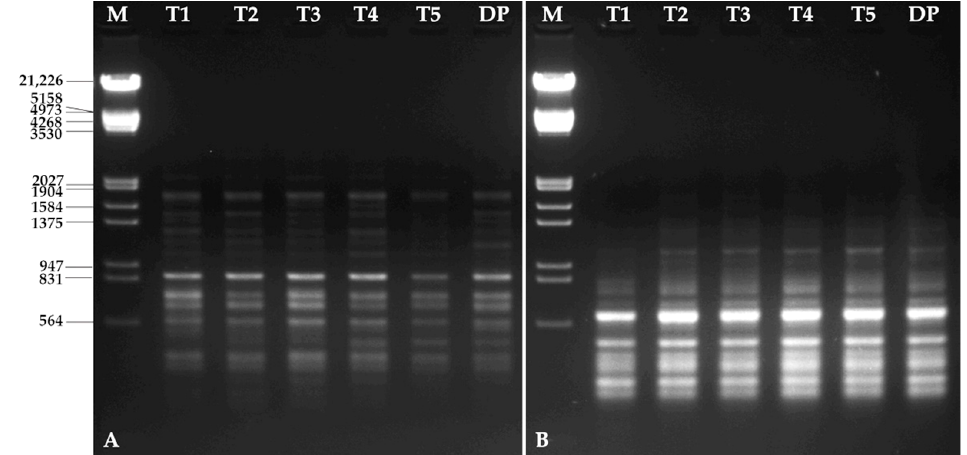
Figure 5. DAMD-PCR profiles of tissue culture and donor plants of Plectranthus amboinicus : ( A ) profile generated using primer HVB5 and ( B ) profile generated using primer 33.6. Lane M = Lambda DNA/EcoRI+HindIII marker; lanes T1–T5 = randomly selected regenerated plants; lane DP = donor plant.